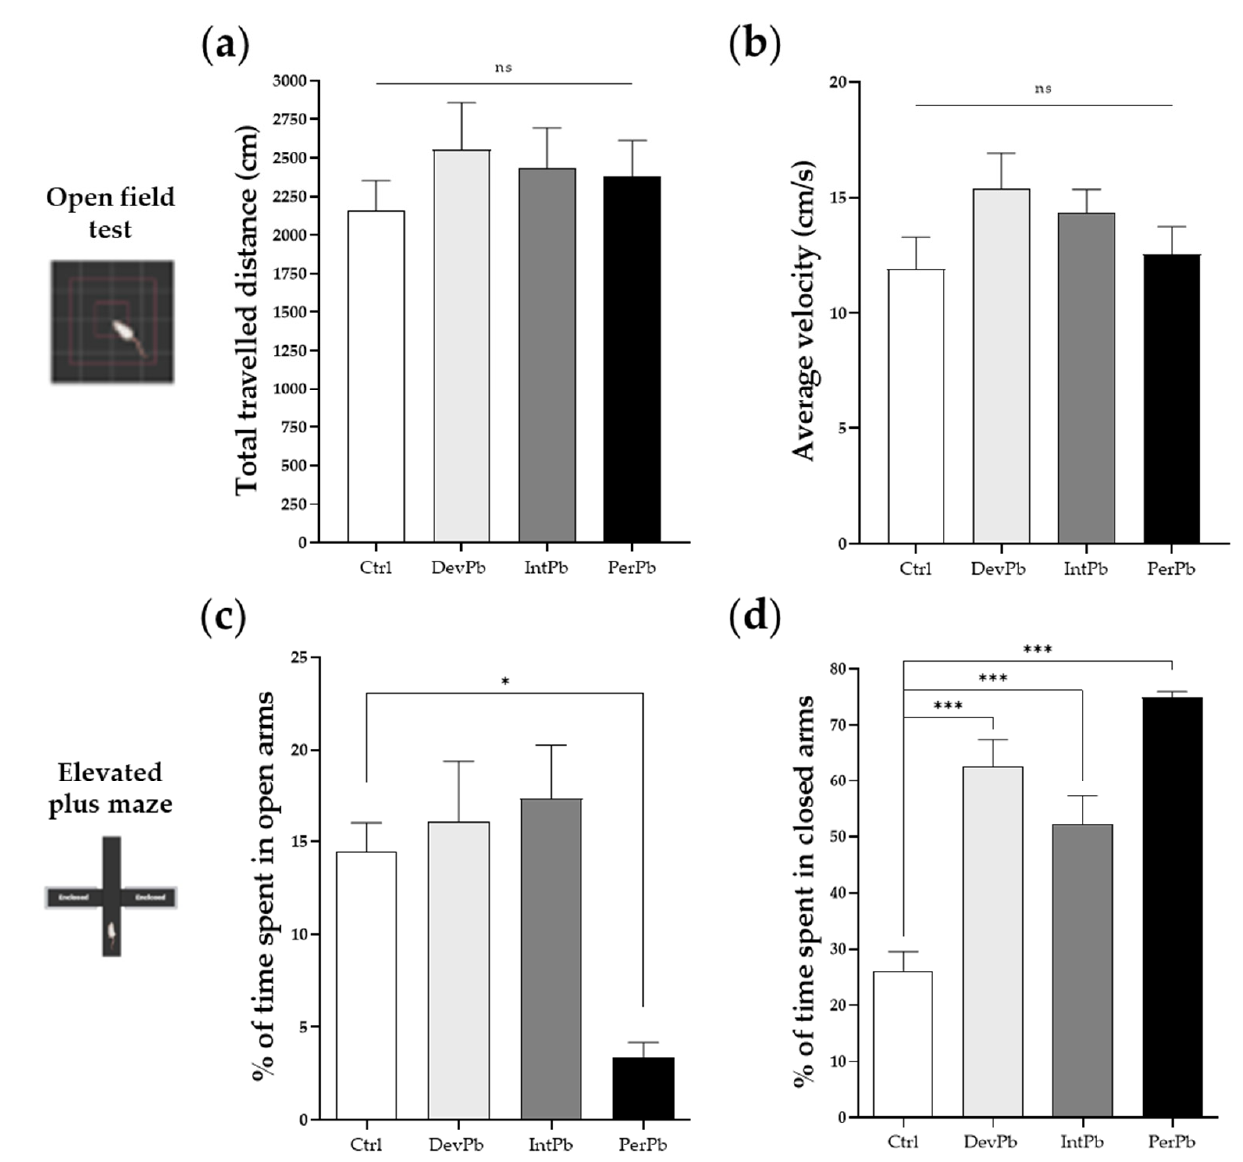
Figure 1. Locomotor and exploratory behaviors and anxiety assessed by the open-field test and elevated plus maze test, respectively: ( a ) Total travelled distance of the animals in the open-field test. ( b ) Average velocity in the open-field test. ( c ) Percentage of time spent in the open arms of the elevated plus maze. ( d ) Percentage of time spent by the animals in the enclosed arms of the elevated plus maze. Values are the mean ± SEM. The asterisks denote statistically significant differences between groups; ns – not significant; * p < 0.05; *** p < 0.001; one-way ANOVA, with multiple comparisons (Dunnett’s test); Ctrl n = 18; DevPb n = 13; IntPb n = 14; PerPb n = 14.